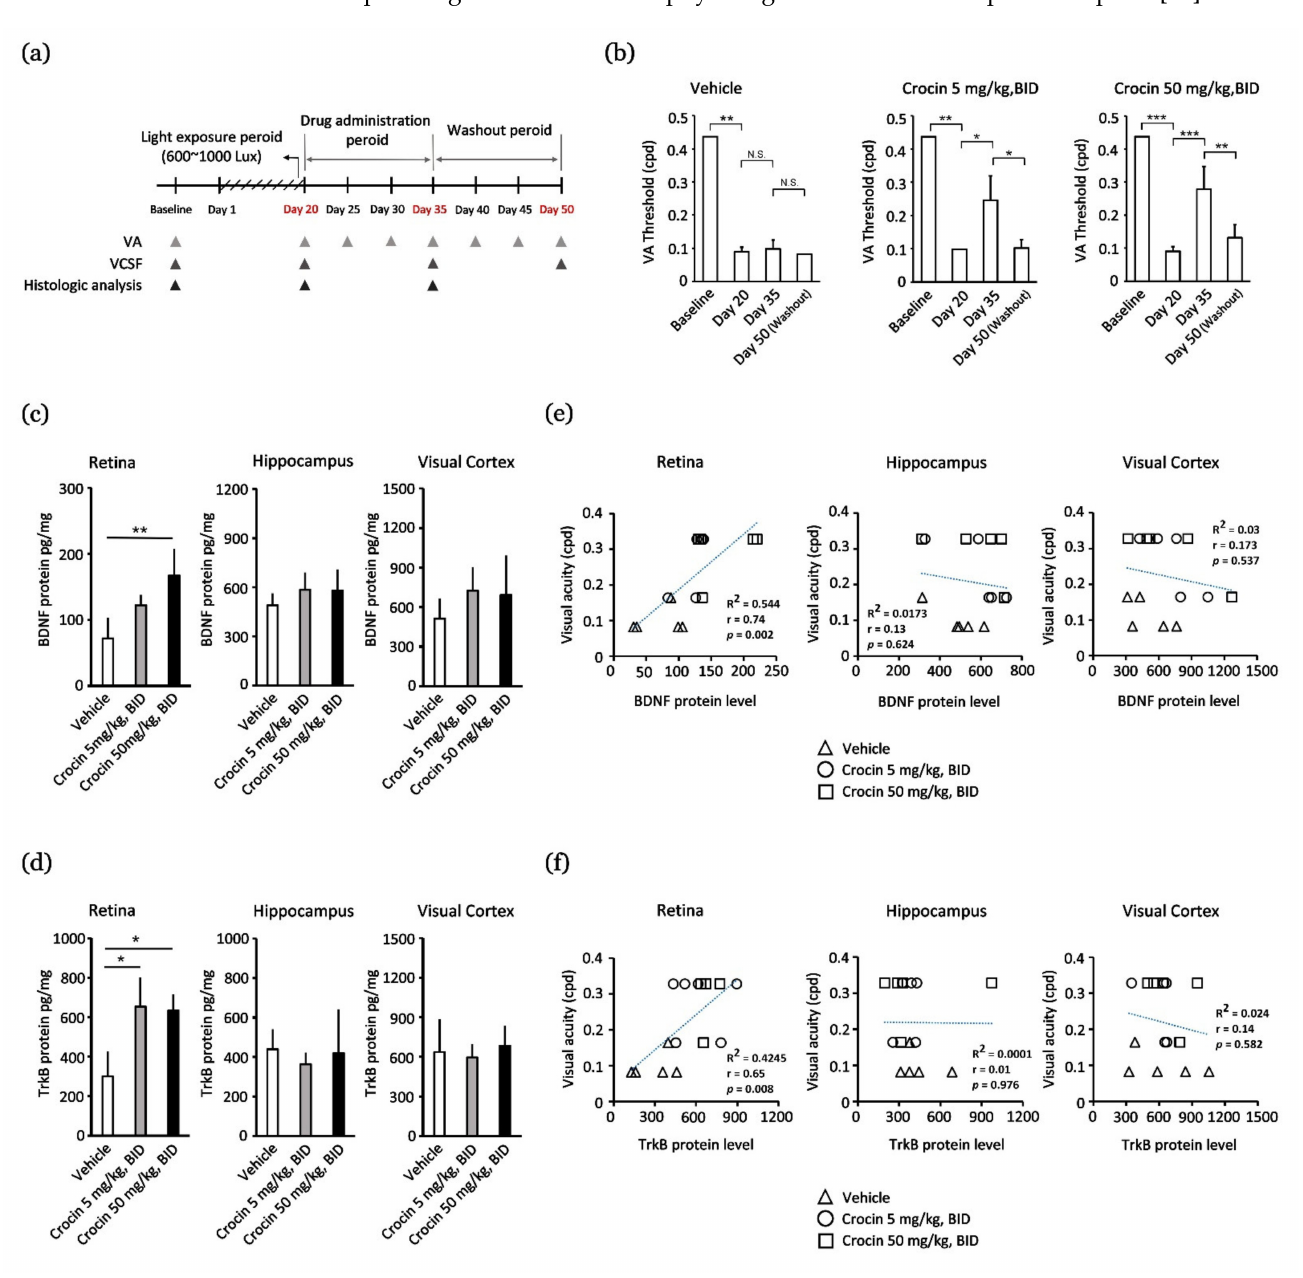
Figure 1. Crocin promotes visual acuity (VA) restoration via upregulating BDNF and TrkB protein content in retinas. ( a ) Timeline of the experimental design (the arrowheads indicate the occurrence at a given time); ( b ) recovery of VA by crocin treatment; ( c ) the BDNF protein content; ( d ) the TrkB protein content; ( e ) the correlation coefficient analysis of BDNF protein content and VA threshold; ( f ) the correlation coefficient analysis of TrkB protein content and VA threshold. Data are expressed as the mean ± standard error (SE). Mann–Whitney U test. *** p < 0.001, ** p < 0.01, and * p < 0.05. BDNF, brain-derived neurotrophic factor; TrkB, tropomyosin receptor kinase B; VCSF, visual contrast sensitivity function; N.S., non-significant; BID, twice a day; cpd, cycles per